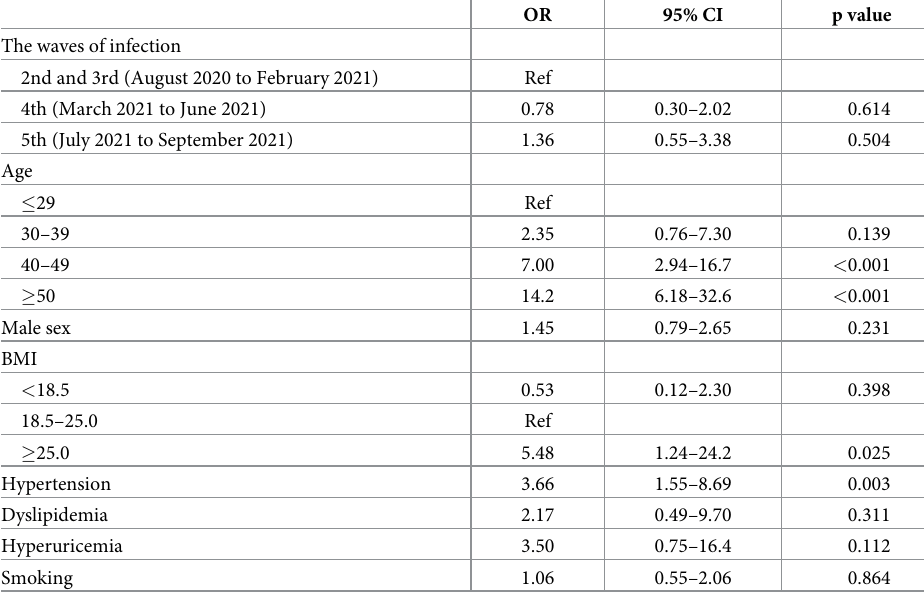
Table 2. Predictors of hospitalization on logistic regression analysis.